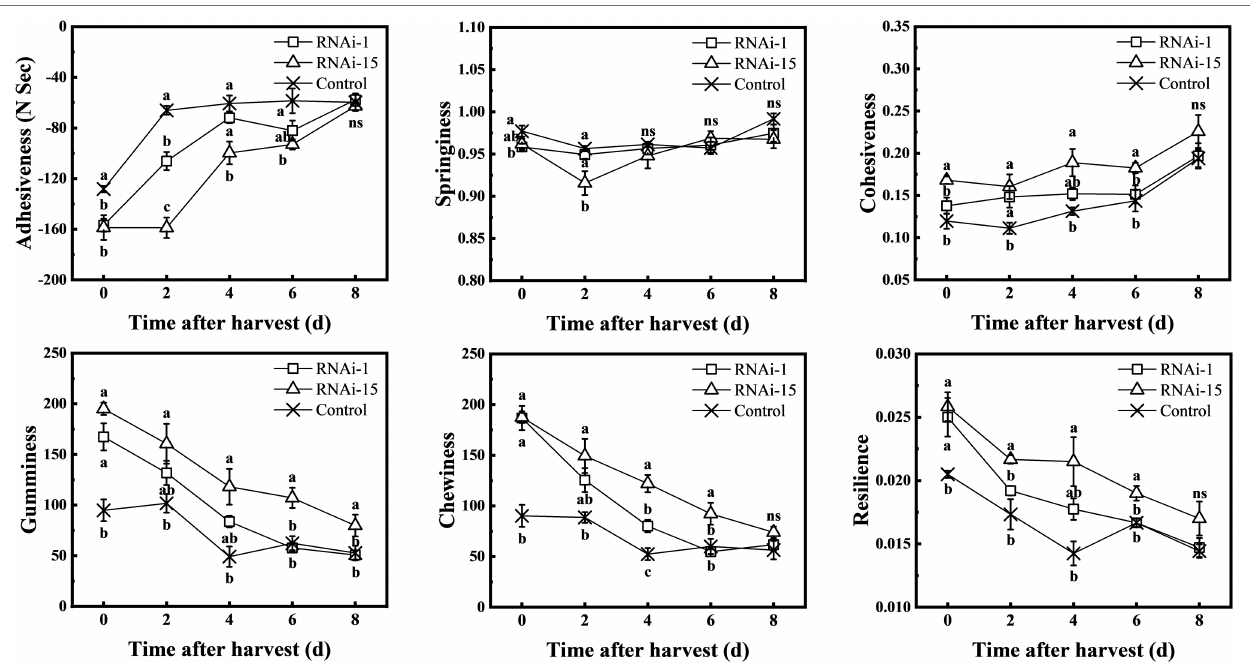
FIGURE 8 | Changes in the texture profile analysis (TPA) parameters during storage of control (TRV2), RNAi-1 (TRV- PpePL1 ), and RNAi-15 (TRV- PpePL15 ). Each values represents the means ± standard error of three replicates. Significant differences ( p < 0.05) between means are indicated by different